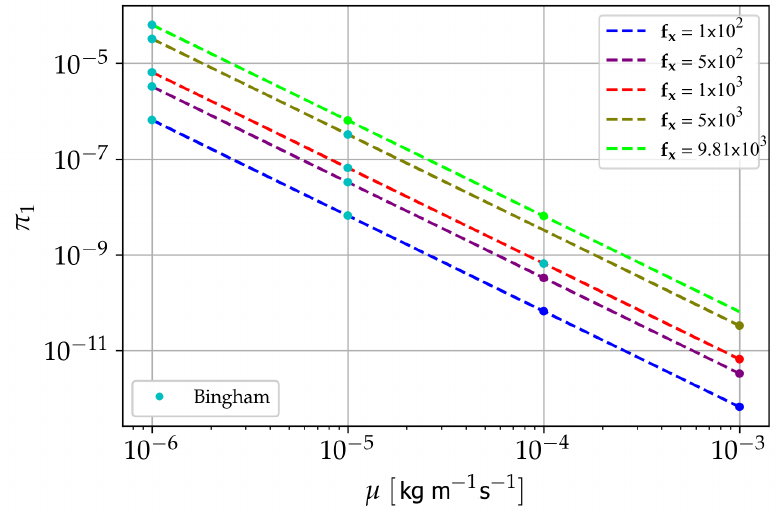
Figure 27. Dimensionless constant π 1 vs. µ at (cid:101) CS = 0 for different values of f x